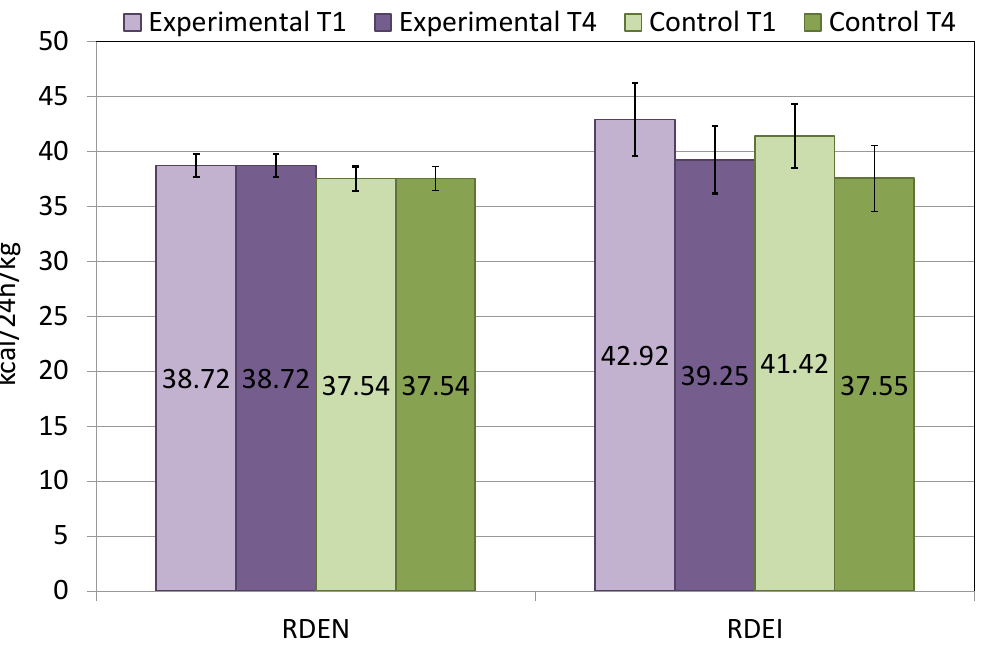
Figure 2. Relative daily energy needs (RDEN) and relative daily energy intake (RDEI) of the swimmers from the experimental (n=12) and the control (n=12) groups on the 1 st (T1) and the 42 nd (T4) days of the six-week training period.